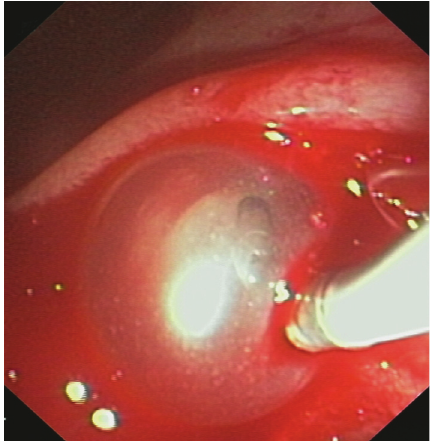
Figure 6: A stone extraction balloon cathether was used for compression.